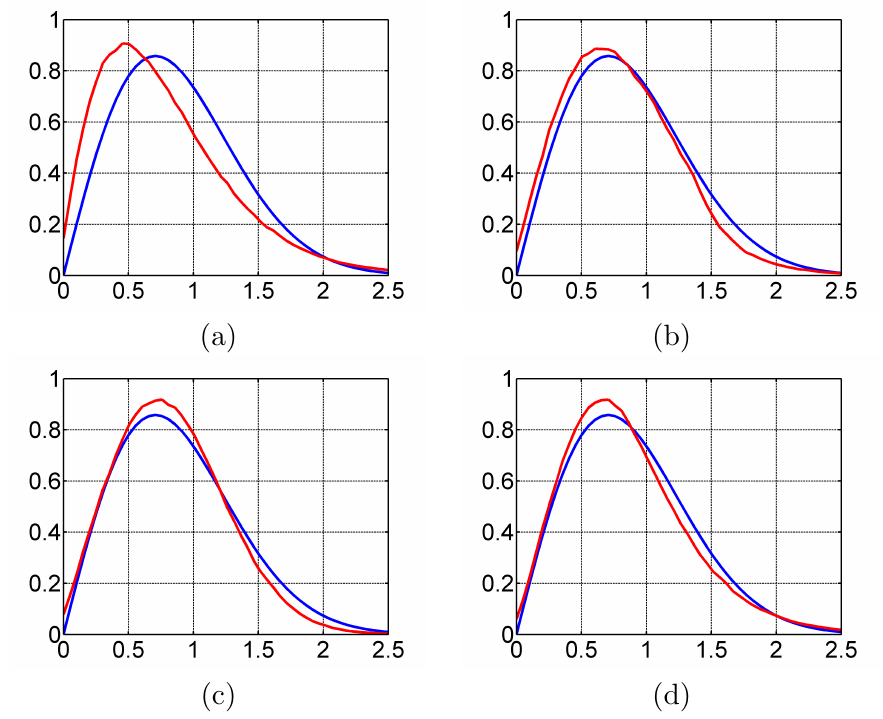
Figure 21. Chicago test case. Overlapping of the theoretical speckle PDF (blue line) and the one related to ratio images in amplitude format in the case of: ( a ) Kuan, ( b ) PPB-it, ( c ) FANS, and ( d ) EWF.